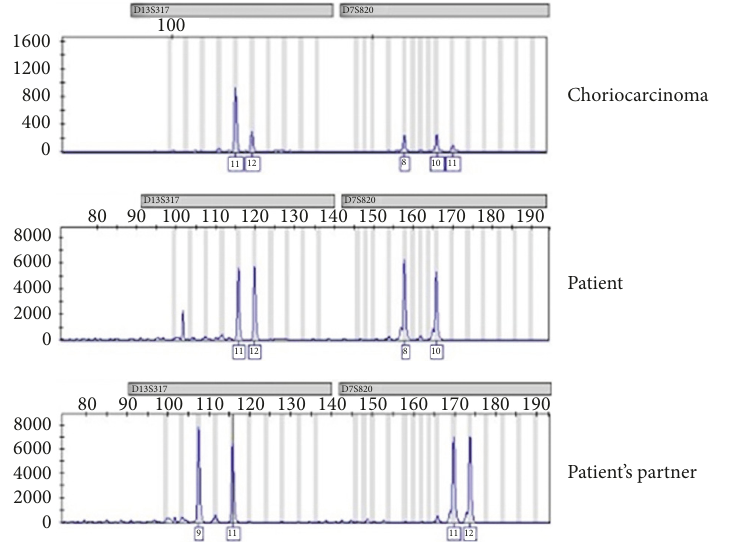
Figure 4: Results of genotyping of two autosomal STR loci (D13S317, D7S820) obtained from choriocarcinoma, patient, and patient’s partner. The choriocarcinoma’s electropherogram shows the presence of three allele for each STR loci. In the D13S317 presents the alleles 11 and 12, patient origin, and allele 11, patient’s partner origin. The D7S820 presents the alleles 8 and 10, patient origin, and allele 11, patient’s partner